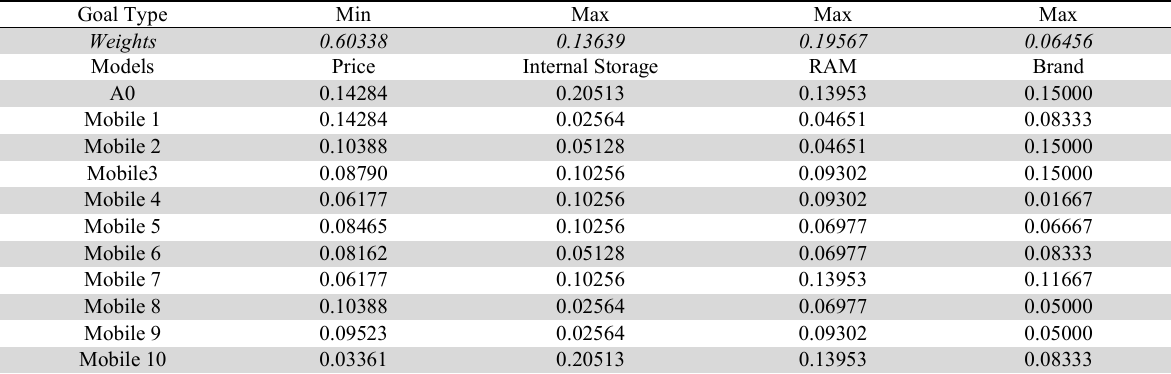
Normalization of the Decision Matrix